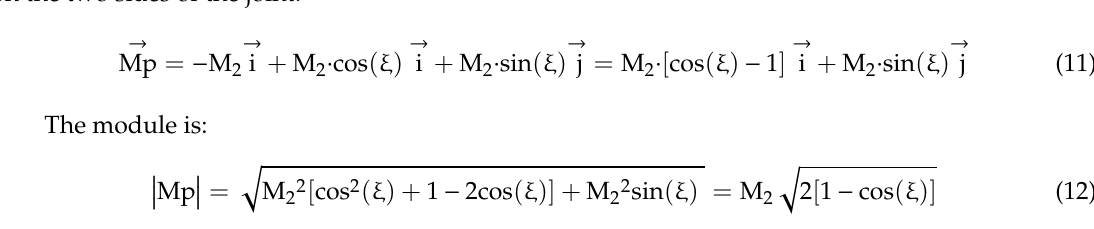
Figure 6. Power balance and secondary torque.